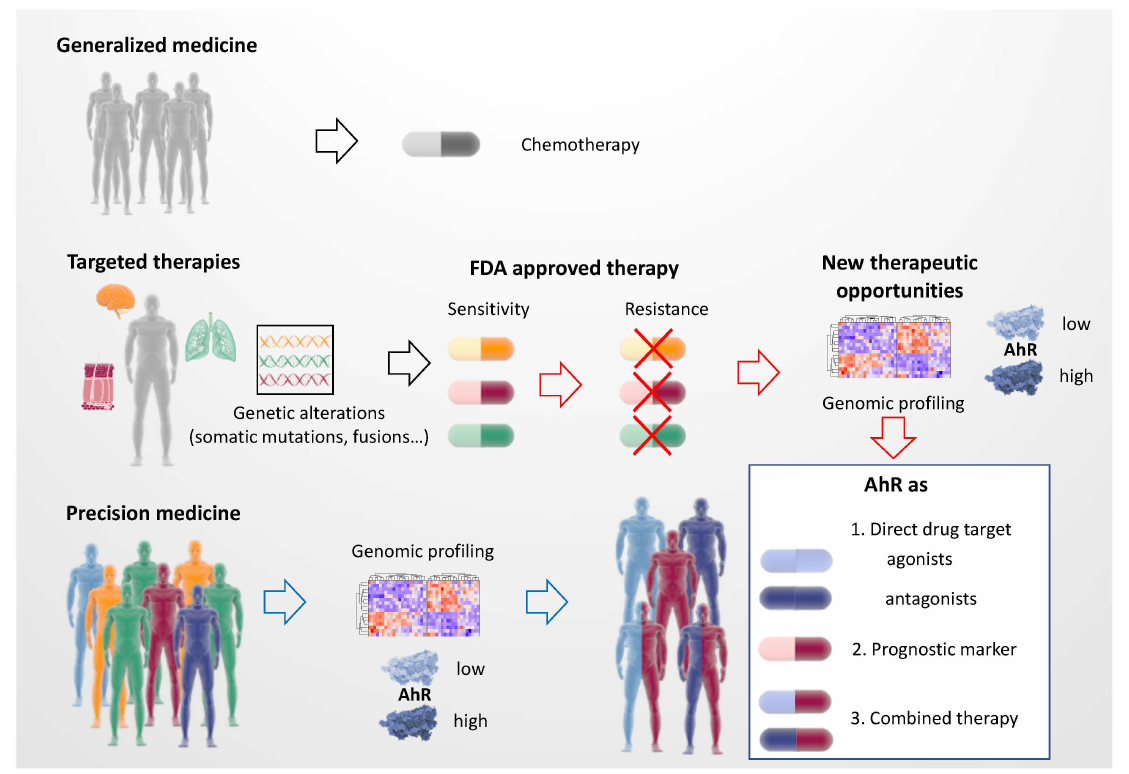
Figure 7. Precision medicine and the personalized therapy of cancer.